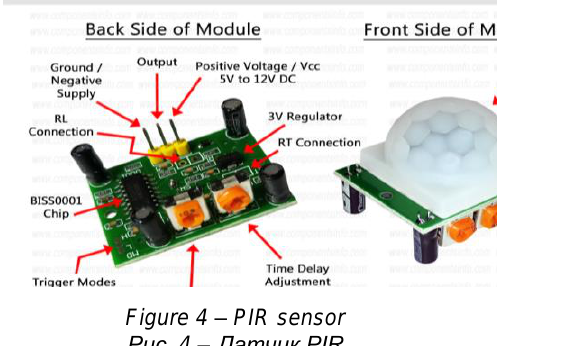
Figure 4 – PIR sensor Рис. 4 – Датчик PIR Слика 4 – ПИР